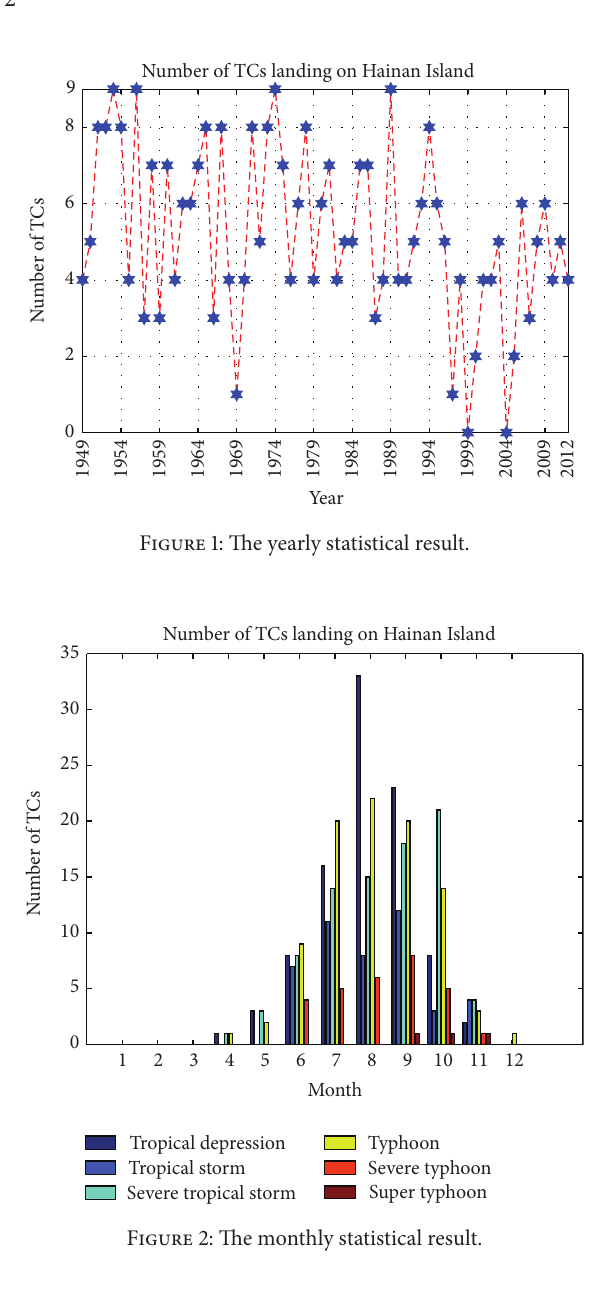
Agency (JMA) and 120/215 km for National